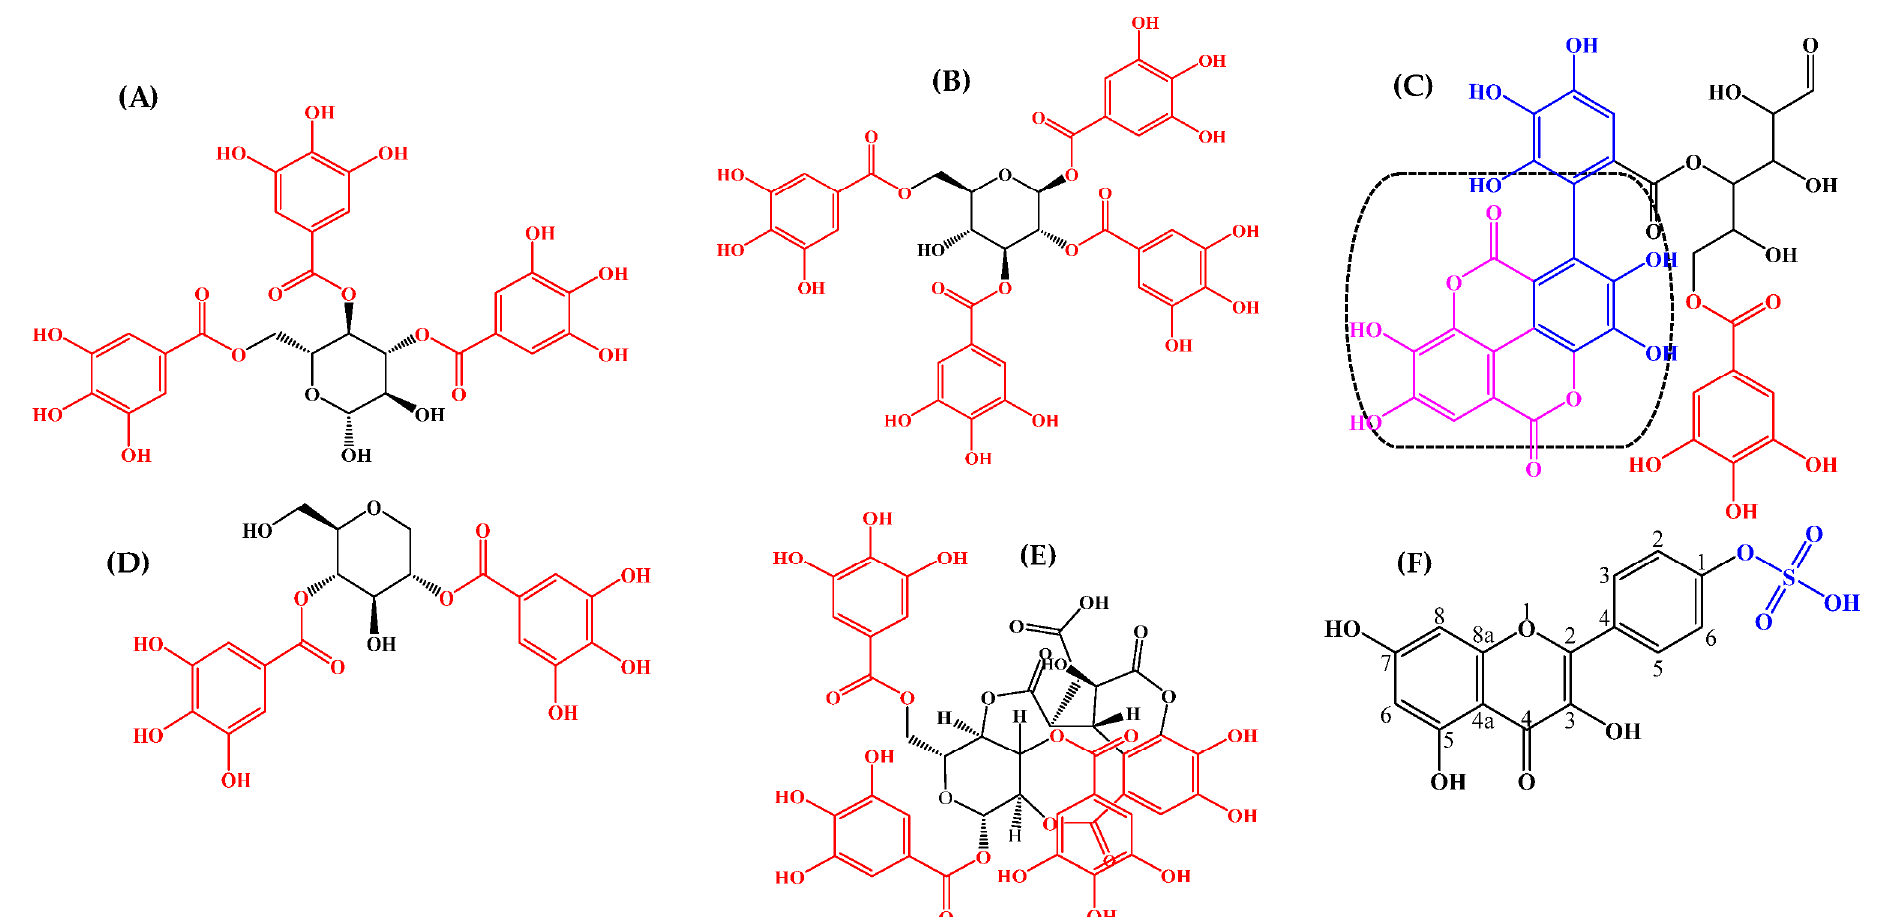
Figure 5. Structures of some compounds in Terminalia brownii leaf ethyl acetate extracts detected in this study. The compound structures were drawn according to the https://scifinder-n.cas.org/ (accessed on 10 May 2022) and https://spectrabase.com/ databases (accessed on 10 May 2022). ( A ) 3,4,6-Tri- O -galloyl-ß-glucopyranose; ( B ) 1,2,3,6-Tetra- O -galloyl-ß-D-glucose; ( C ) Terflavin-B; ( D ) Di- O -galloyl derivatives (Maplexin D); ( E ) Chebulinic acid (Eutannin); ( F ) Kaempferol-4'-sulfate. Galloyl group highlighted with the red color; hexahydroxydephinic acid (HHDP) in terflavin-B highlighted with blue color; the dashed shape is the ellagic acid part in terflavin-B.